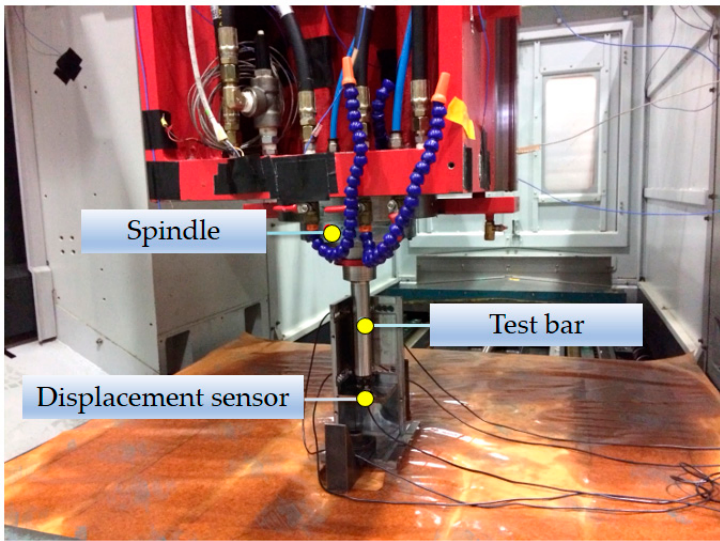
Figure 2. Installation description of the displacement sensor and test bar.